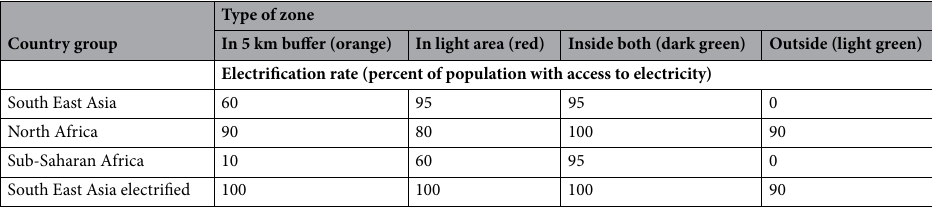
Table 1. Criteria used to calculate the relative size of the unelectrified population (per pixel, depending on the type of zone where the pixel is located, and the corresponding country group). Source: Authors’ compilation based on the analysis.